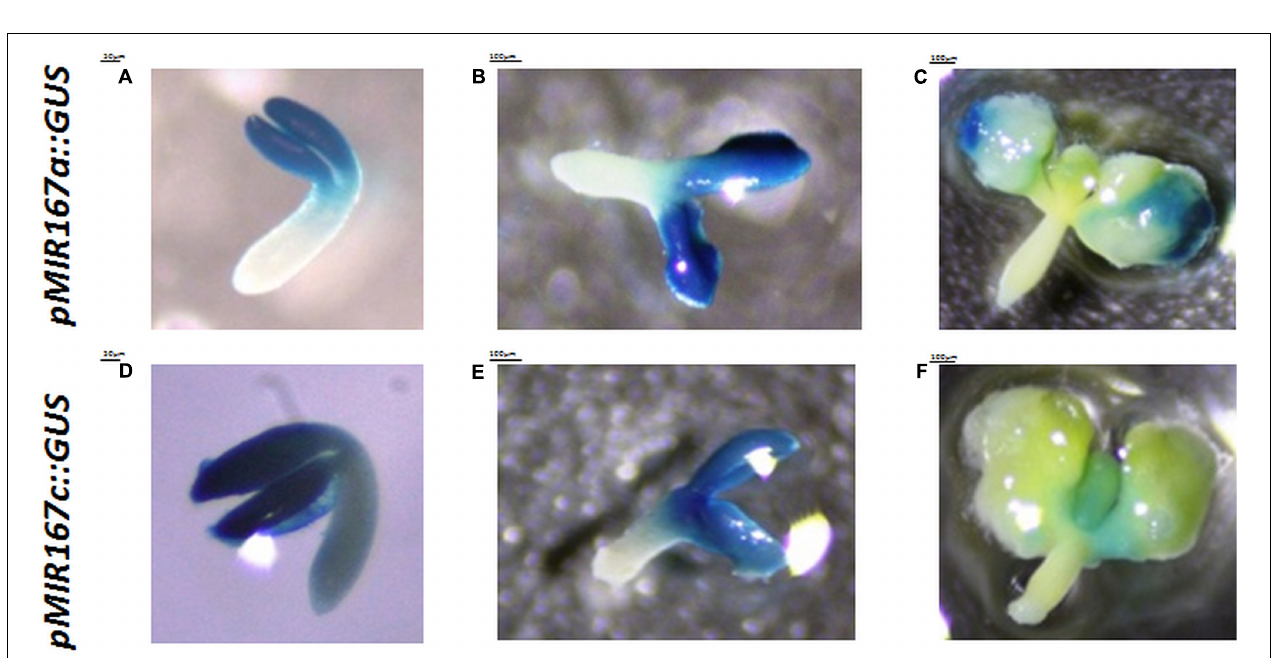
FIGURE 3 | Patterns of the activity of the GUS-monitored promoters of the MIR167a (A–C) and MIR167c (D–F) genes at 0th day (A,D) , 5th day (B,E) , and 10th day (C,F) of the SE culture.